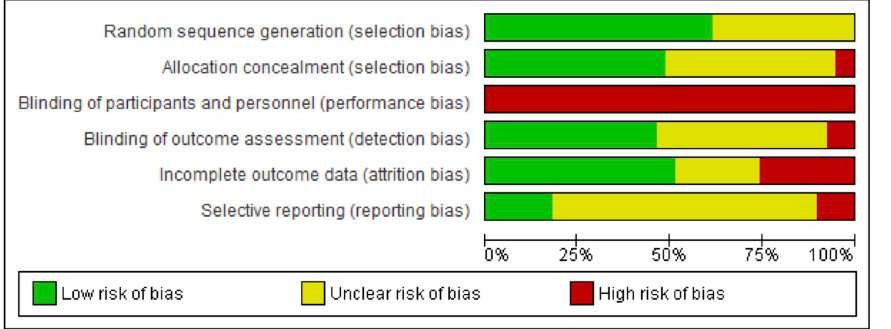
Fig 2. Overview of risk of bias scorings for included completed